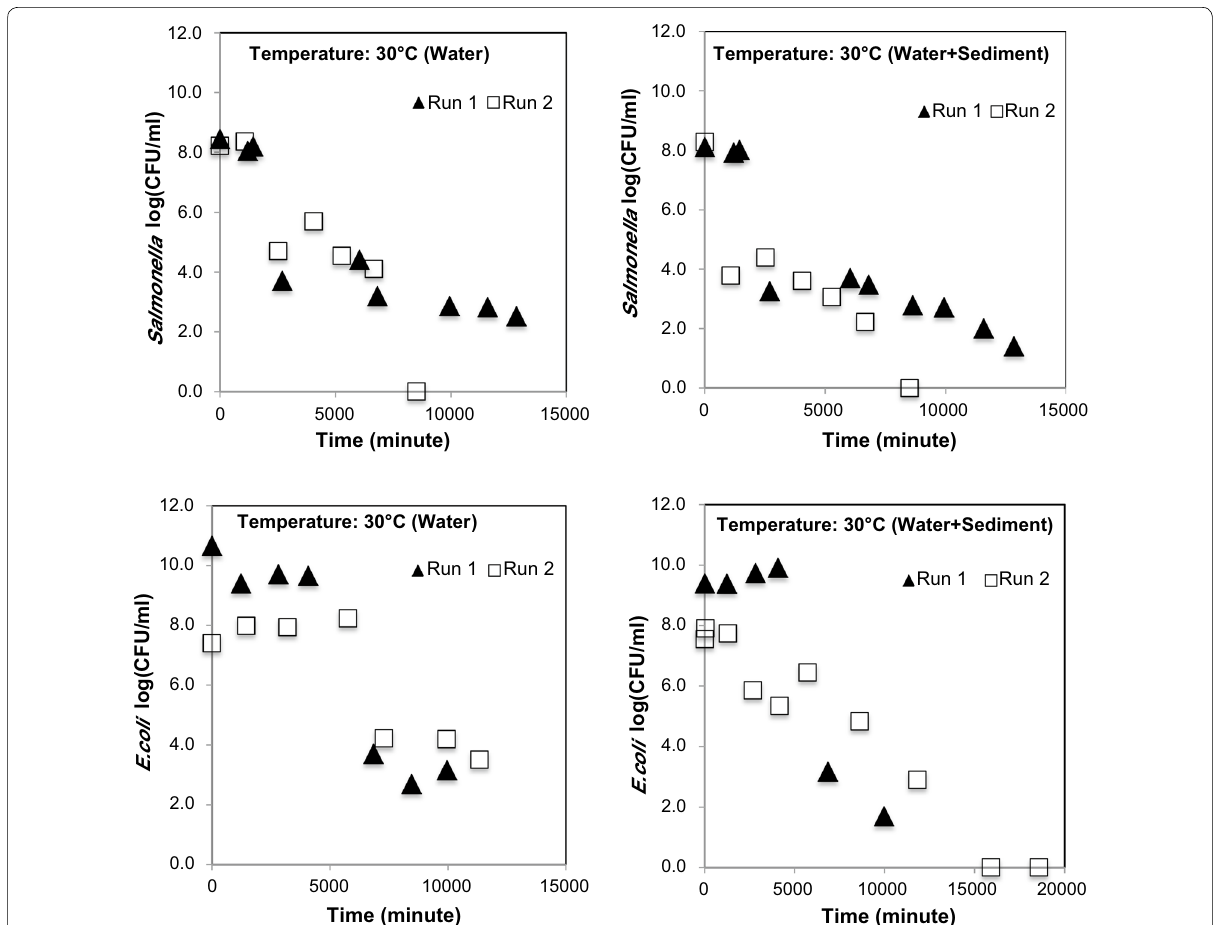
Fig. 3 Survival of Salmonella and E. coli O157:H7 and at 30 °C (mesophilic temperature) in free floating and particle attached